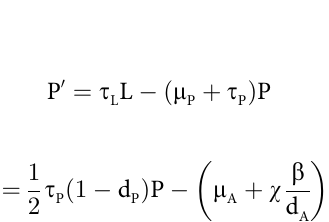
Fig 2. Schematic representation of the computational framework. Mathematical models (yellow boxes) take as inputs recorded temperature and entomological data (blue boxes) to estimate mosquito abundance, West Nile virus prevalences in the bird and vector populations and human transmission risk (green boxes).